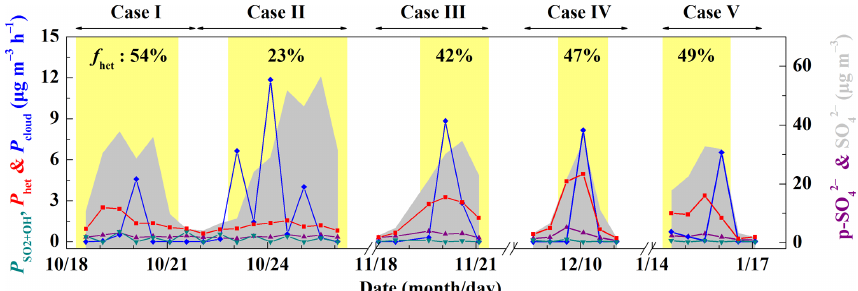
Figure 4. Estimate of different sulfate production pathways. Time series of estimated sulfate production rate via OH oxidation in the gas phase ( P SO ), overall heterogeneous reactions on aerosols ( P het ) and in-cloud reactions ( P cloud ), and concentrations of primary sulfate 2 + OH (p-SO 2 − ) and observed sulfate. f het represents the fraction of overall heterogeneous sulfate production to total sulfate production during 4 PDs of each case. The light yellow shaded area indicates polluted days (PDs, PM 2 . 5 ≥ 75µgm − 3 ). Data used here are 12-hourly averaged values, corresponding with filter samples.